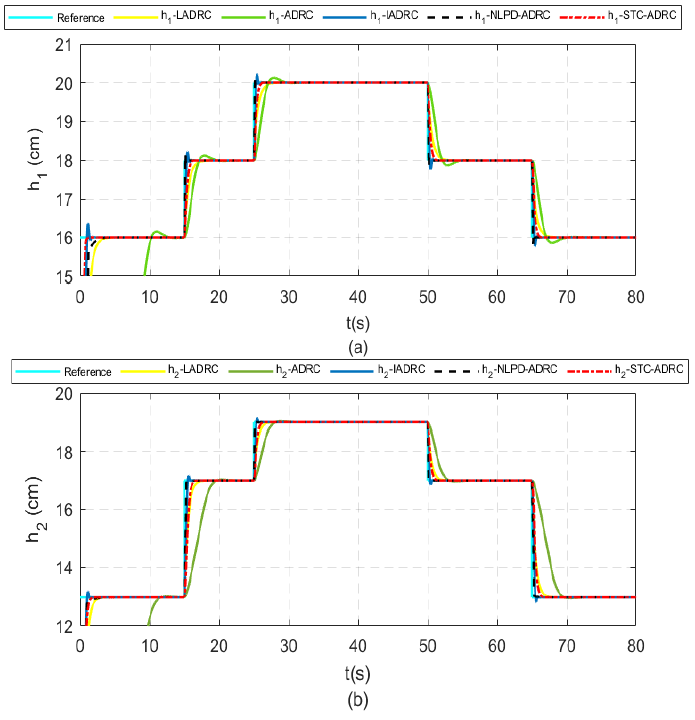
Figure 9. The water level under different time-varying references using the 1 st MADRC scheme. ( a ) 1 st subsystem. ( b ) 2 nd subsystem.